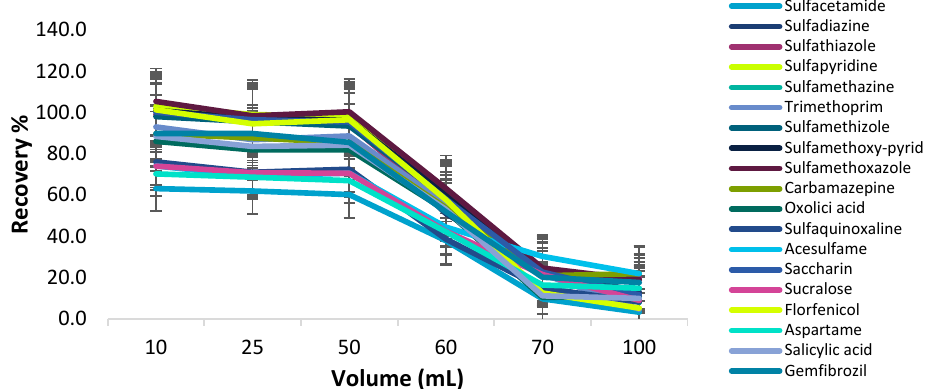
Figure 7. Effect of sample volume on Fe 3 O 4 @GO-MSP.